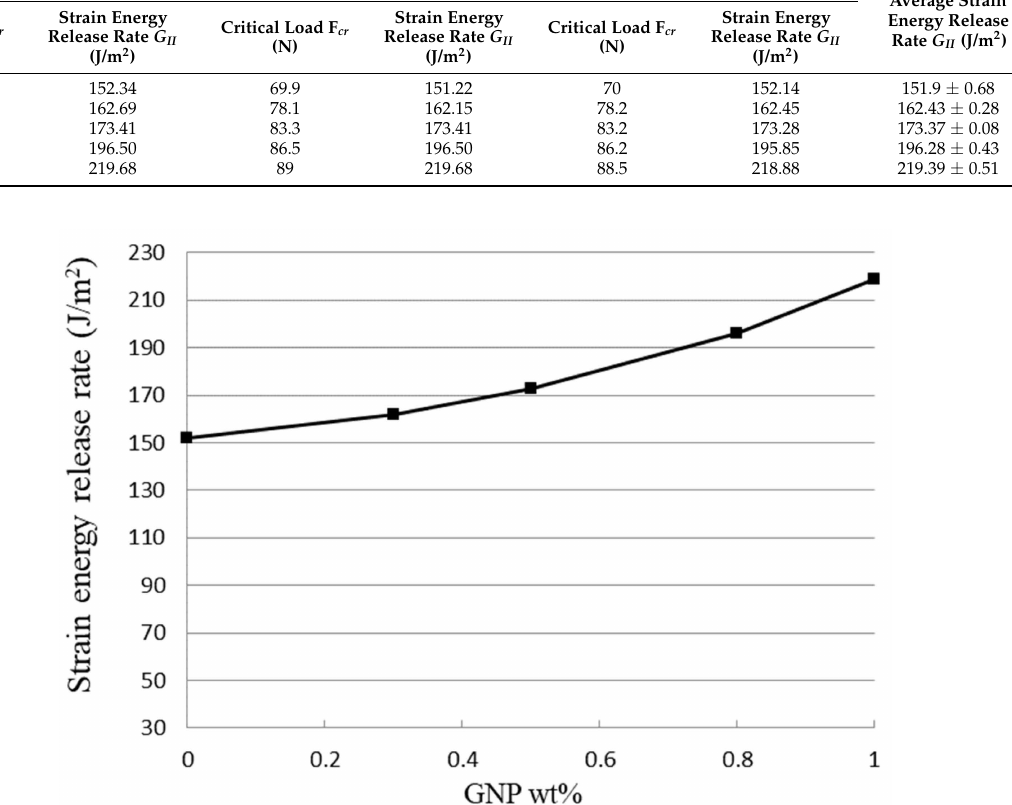
Figure 11. Mode II fracture toughness of nanocomposite film/substrate composite structure rein- forced with various GNP